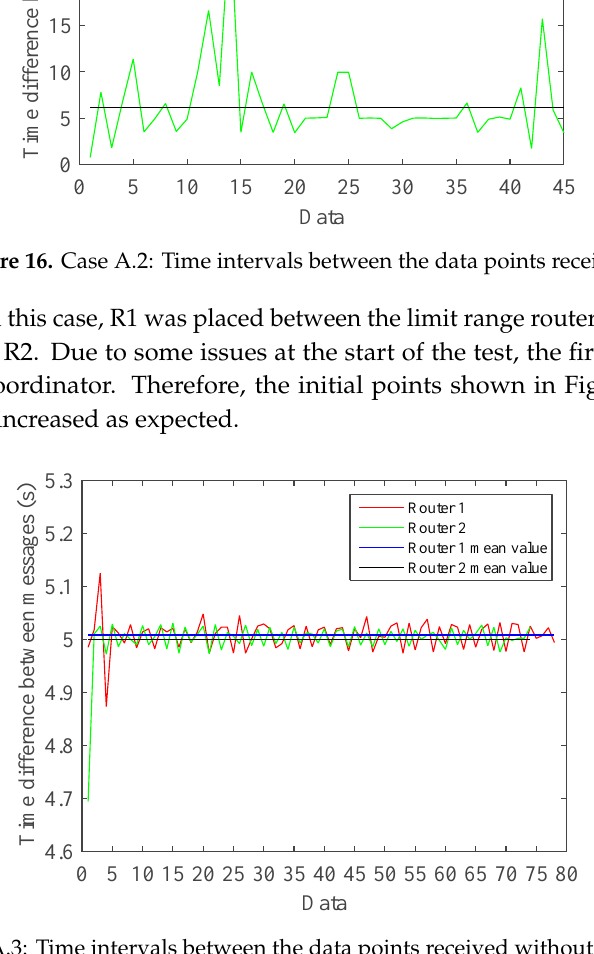
Figure 17. Case A.3: Time intervals between the data points received without the initial points.